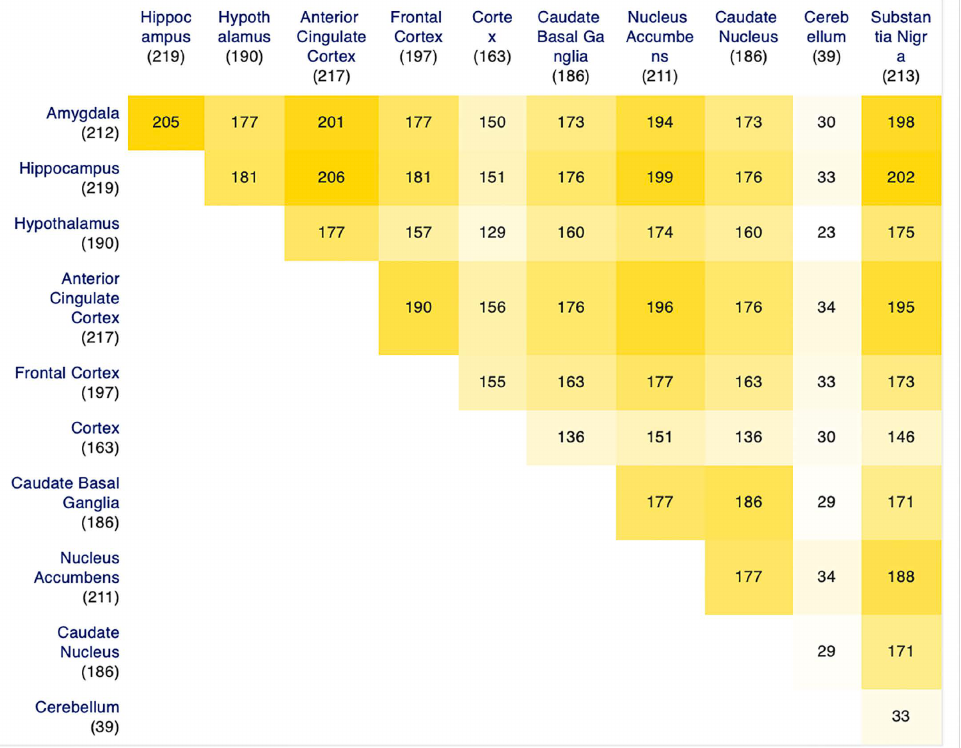
Figure 3. Intersections of the MADgs genes found co-expressed in 11 brain